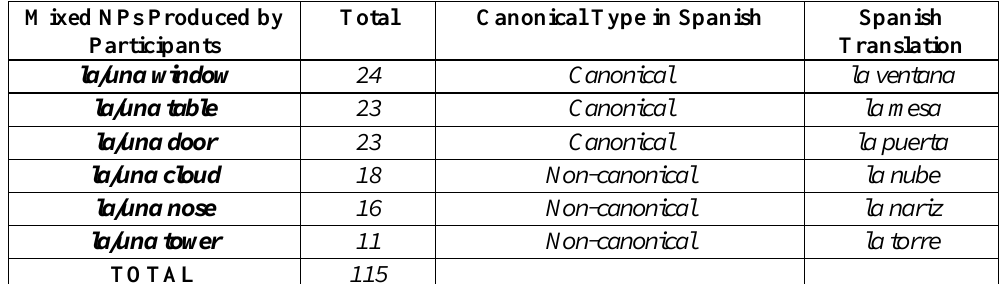
Table 9. Mixed NPs produced using the analogical strategy during forced toy task (i.e., stimuli with Spanish feminine translation equivalents) Mixed NPs Produced by